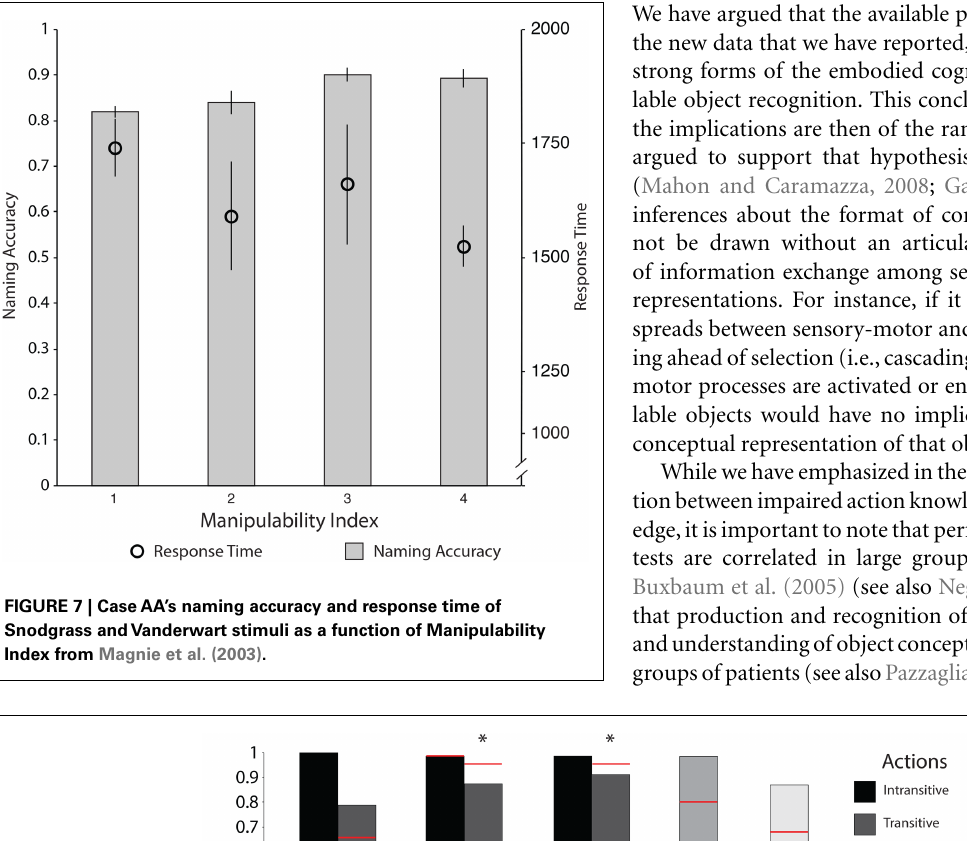
Frontiers in Human